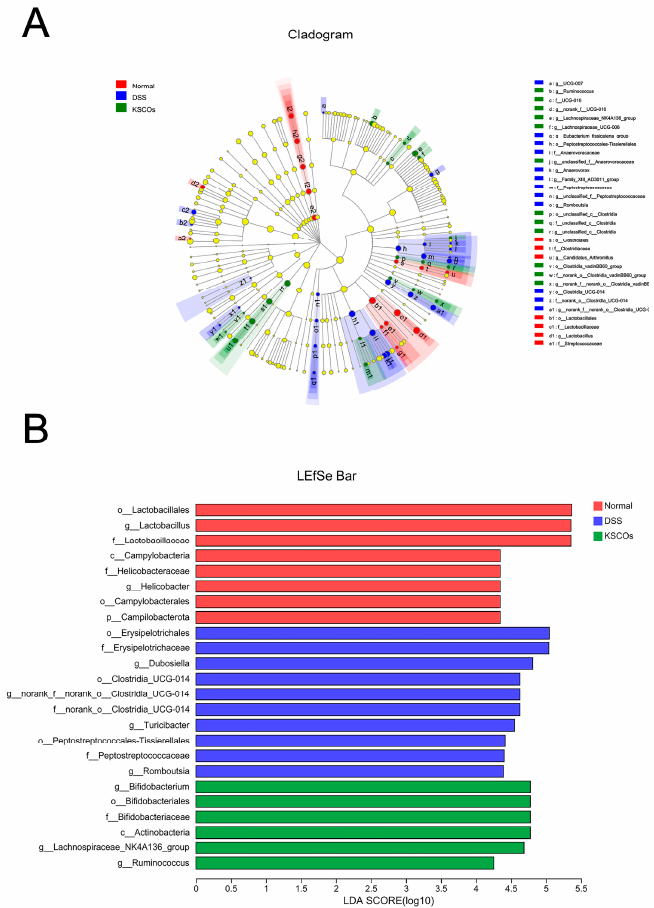
Figure 7. Differences in composition of the gut microbiota among the normal, DSS, and KSCOs groups: ( A ) cladogram of LEfSe analysis; ( B ) histogram of the LDA scores.